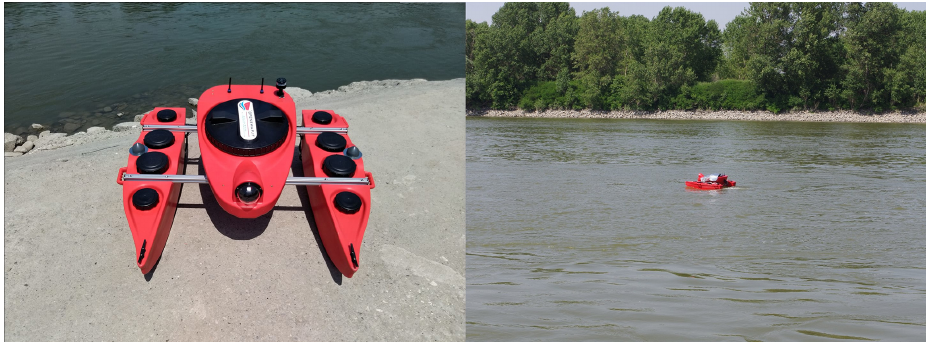
Figure 7. Proambiente’s unmanned survey vehicle, during the field measurement session at the Po River during W.A.T.E.R. 2019.